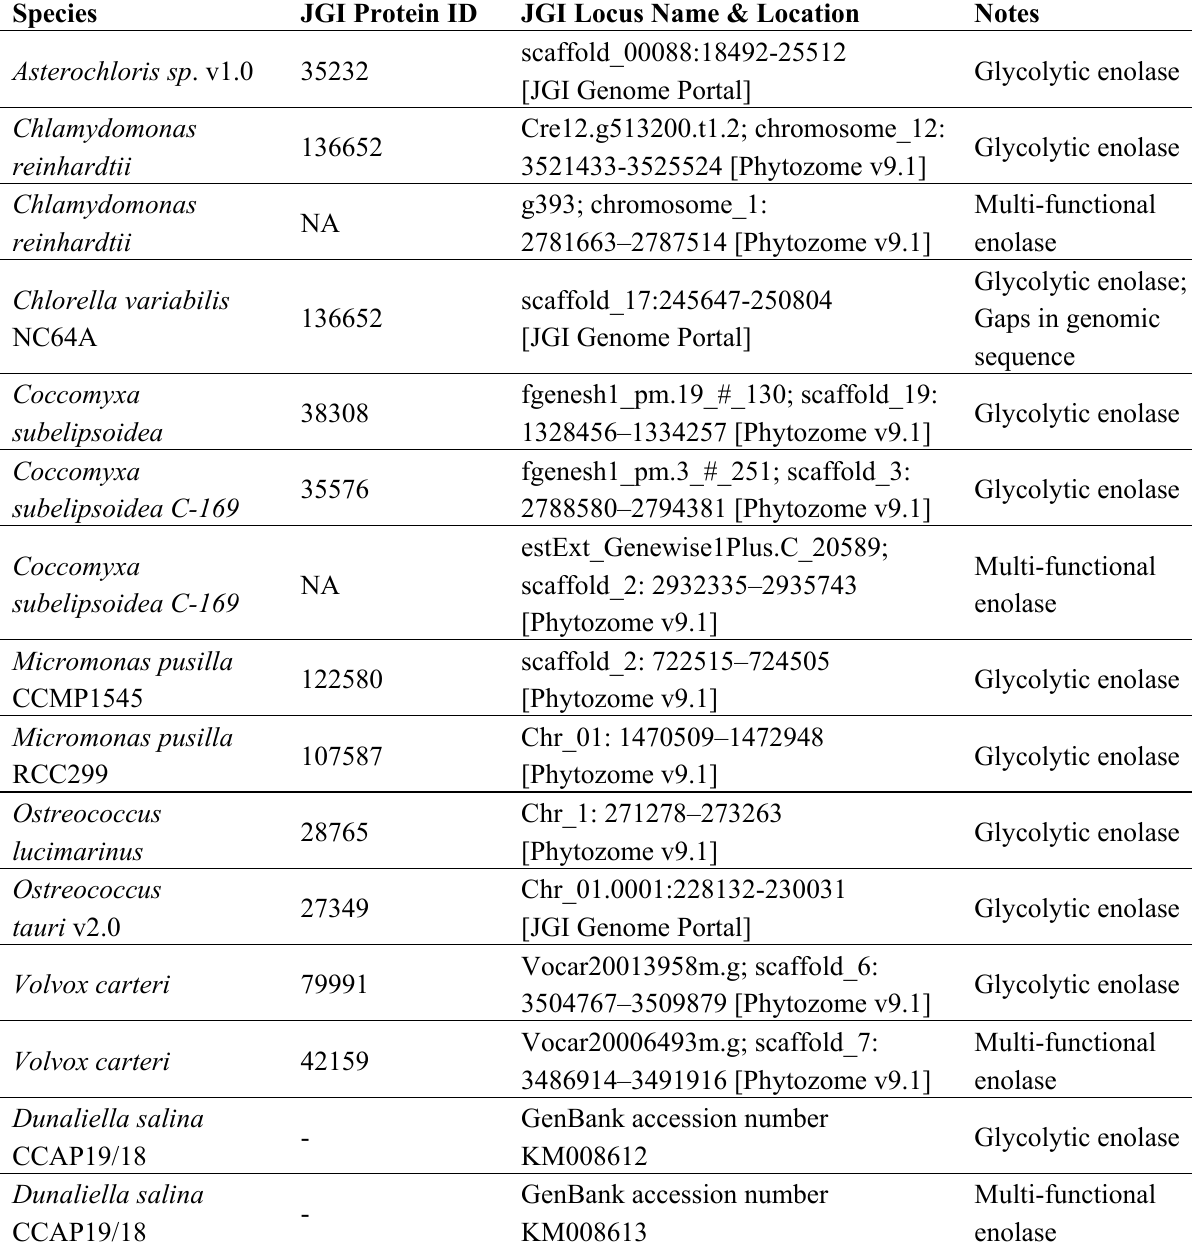
Table 1. Information on the genes coding for the enolase in green algae as extracted from the database of the US Joint Genome Institute (as of 23 May